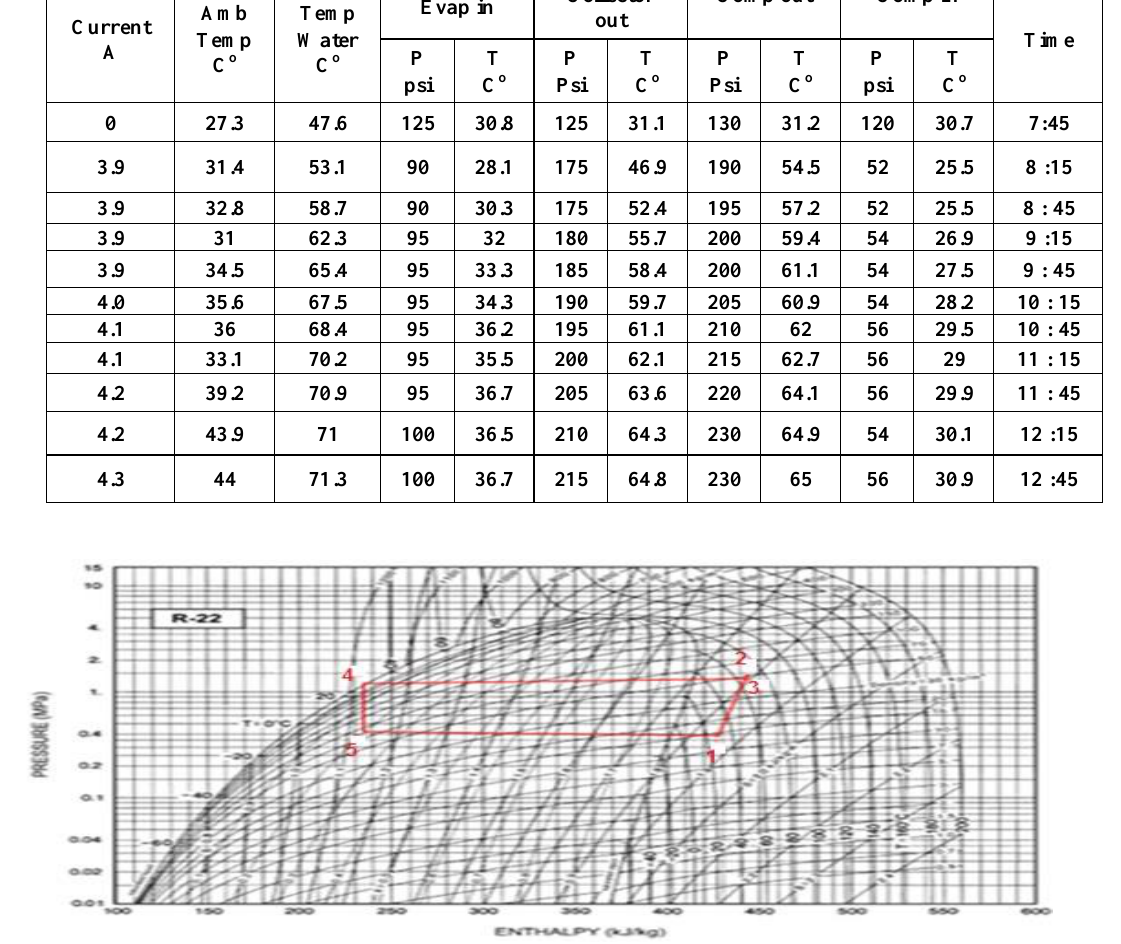
Fig. 11: P-h chart with water